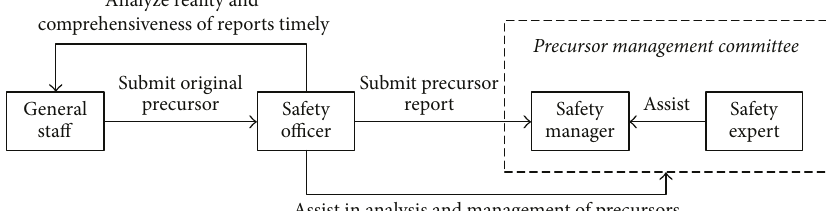
Figure 9: The proposed organization structure.